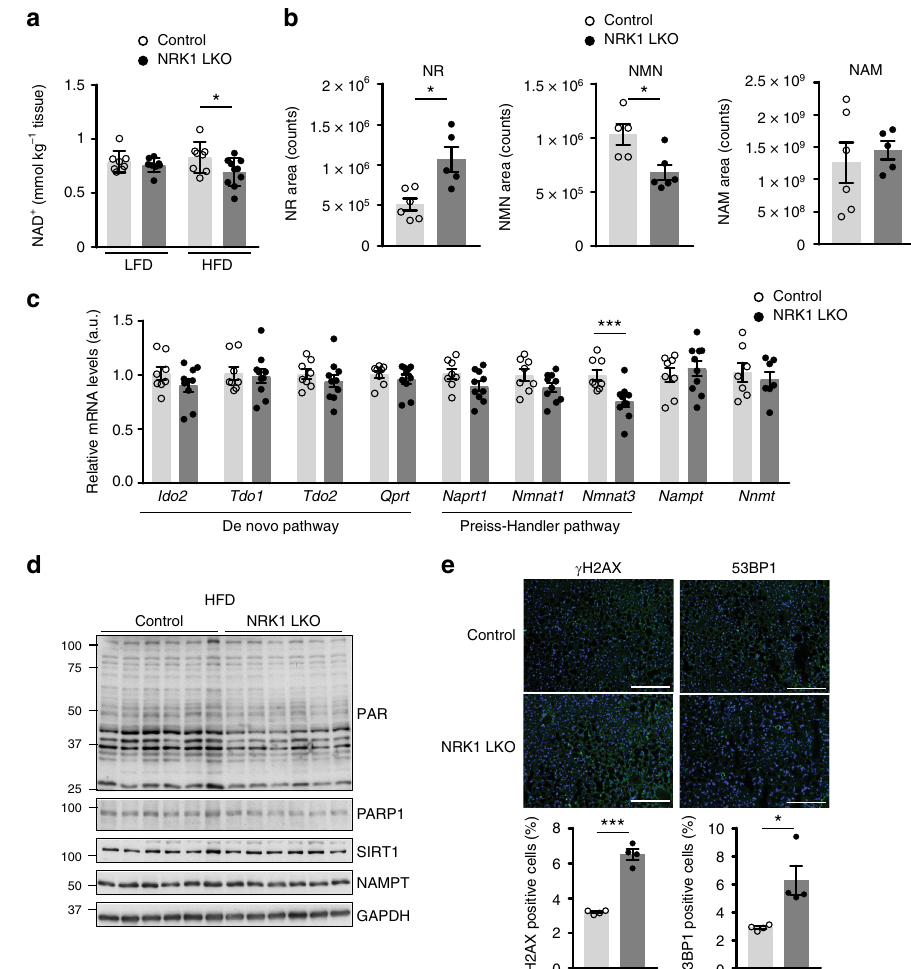
Fig. 5 NRK1 deletion curbs PARP activity and exacerbates DNA damage. a NAD + levels in the liver of NRK1 LKO mice upon LFD and HFD (n = 8 for all groups except NRK1 LKO on HFD, n = 10; 24 weeks of age). b NR (left), NMN (center) and NAM (right) levels in the liver of NRK1 LKO and control mice upon HFD ( n = 6 mice per group). c mRNA level of genes involved in the NAD + biosynthesis pathways (n = 8 mice for the control group, n = 10 mice for the NRK1 LKO group). d Levels of poly(ADP-ribose) protein modi fi cation, PARP1, SIRT1, NAMPT, and GAPDH in the liver of NRK1 LKO and control mice on HFD. e Representative staining (top) and quanti fi cation (bottom) of γ H2AX (left) and 53BP1 (right) immuno fl uorescence on liver sections from NRK1 LKO and control mice on HFD ( n = 4 mice per group, ×10 magni fi cation, DAPI counterstaining, scale bars: 200 μ m). Results shown are mean ± SEM, * and *** indicate statistical difference vs. control group at p < 0.05 and p < 0.001, respectively. The individual values and statistical tests used for each panel can be found in the Source Data fi